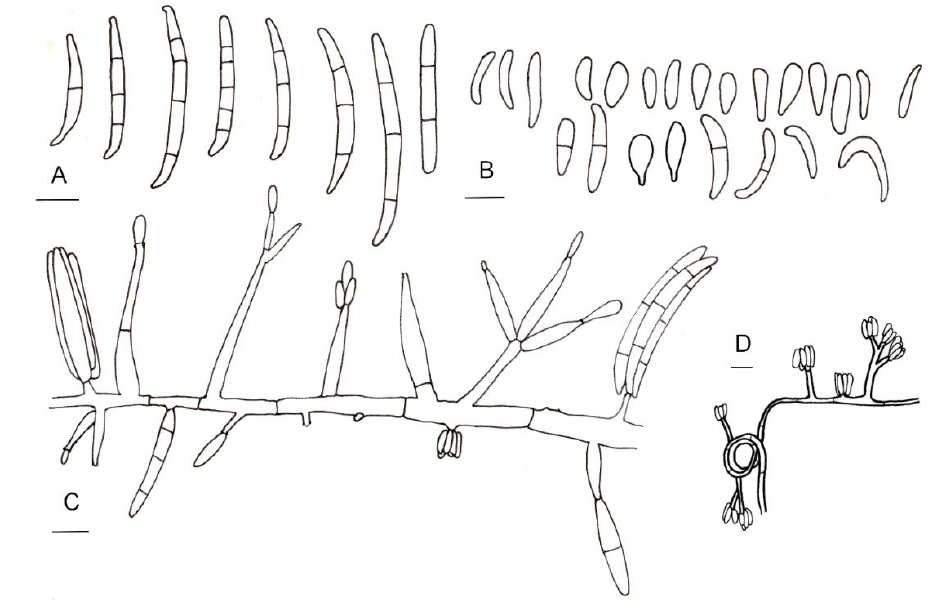
Figure 3. Line drawings of morphological characters of Fusarium casha . ( A ) Macroconidia. ( B ) Microconidia. ( C ) Conidiophores and conidiogenous cells. ( D ) Conidia produced in false heads and hyphae coiling in circles. Bars: 5 µm.